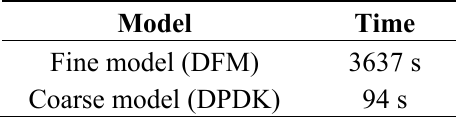
Figure 19. Water saturation profiles at PVI = 1.0 for case 3: ( a ) matrix medium of fine model; ( b ) fracture medium of fine model; ( c ) matrix medium of coarse model; ( d ) fracture medium of coarse model. Table 7. Simulation time for case